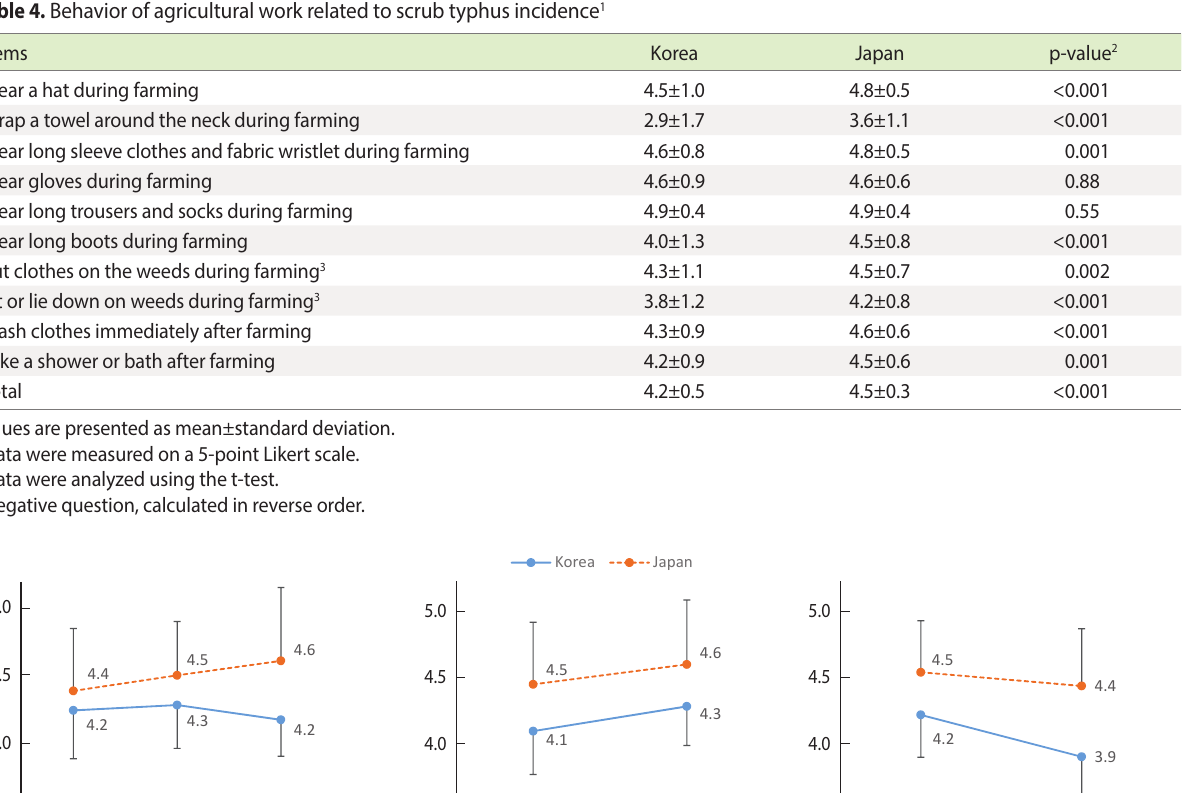
Table 4. Behavior of agricultural work related to scrub typhus inci dence 1